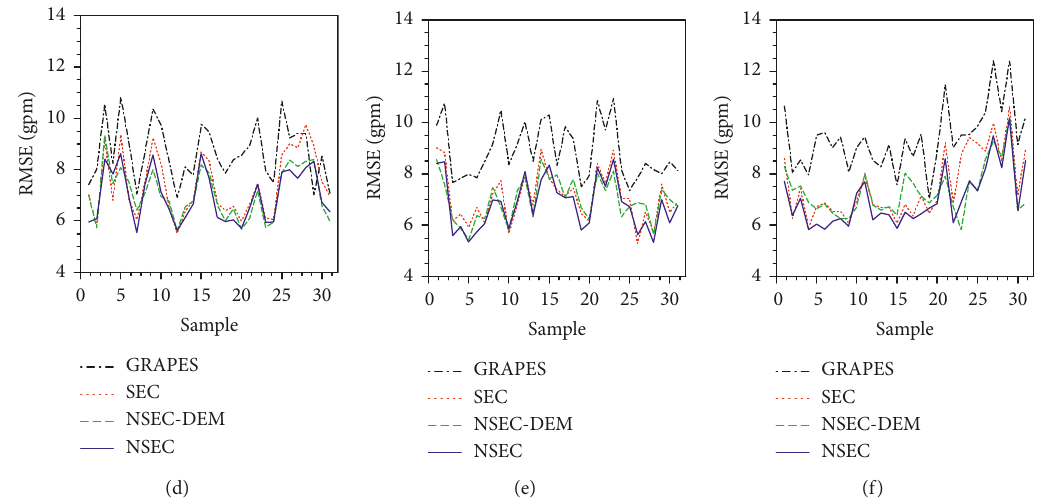
Figure 5: RMSE of 500hPa geopotential height of 24h forecast at January (a, b, and c) and July (d, e, and f) of 2008, 2009, and 2010. The black lines (GRAPES) denote GRAPES model forecast, red lines (SC) to the forecast after system correction, blue lines (NSC) to the forecast after correction of nonsystematic error, and green lines (NSEC-DEM) to the forecast after correction of nonsystematic error by DEM approach [23]. Table 3: Average of RMSE of test samples of geopotential height on 500hPa (unit: gpm). Test month GRAPES model Systematic error correction Nonsystematic error correction of DEM Nonsystematic error correction 2008